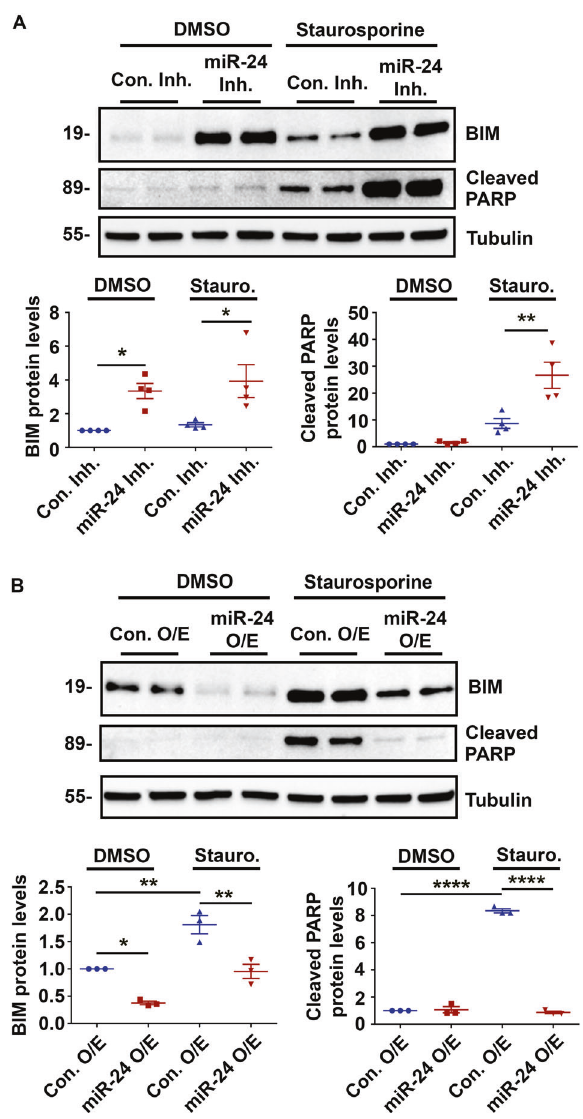
Fig. 7 miR-24-3p regulates the pro-apoptotic protein BIM in intestinal epithelial cells. A Western blots and densitometric analysis of BIM, cleaved PARP and Tubulin from SW480 cells treated with control or the miR-24-3p inhibitor in the presence or absence of staurosporine. Four independent experiments. Mean ± SEM. B Western blots and densitometric analysis of BIM, cleaved PARP and Tubulin from cells treated with control or miR-24-3p mimic in the presence or absence of staurosporine. Three independent experiments. Mean ± SEM. * p < 0.05; ** p < 0.01; **** p <